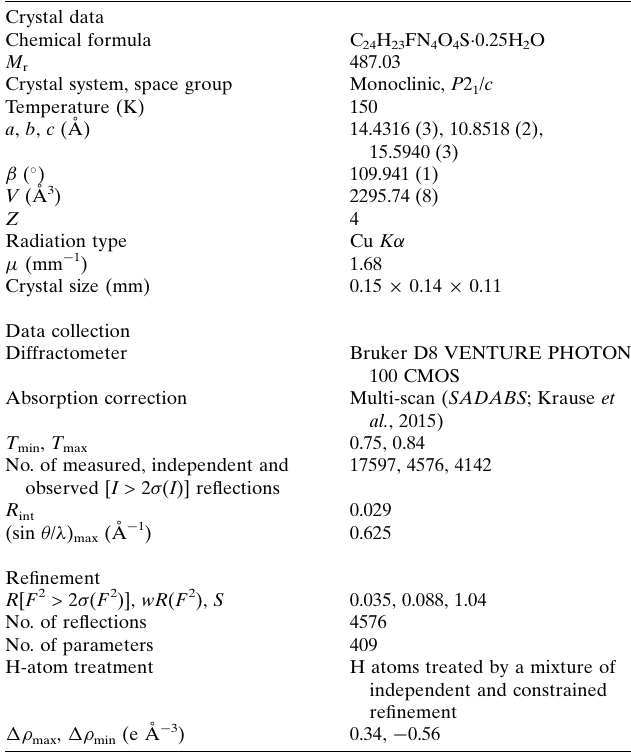
Crystal data Chemical